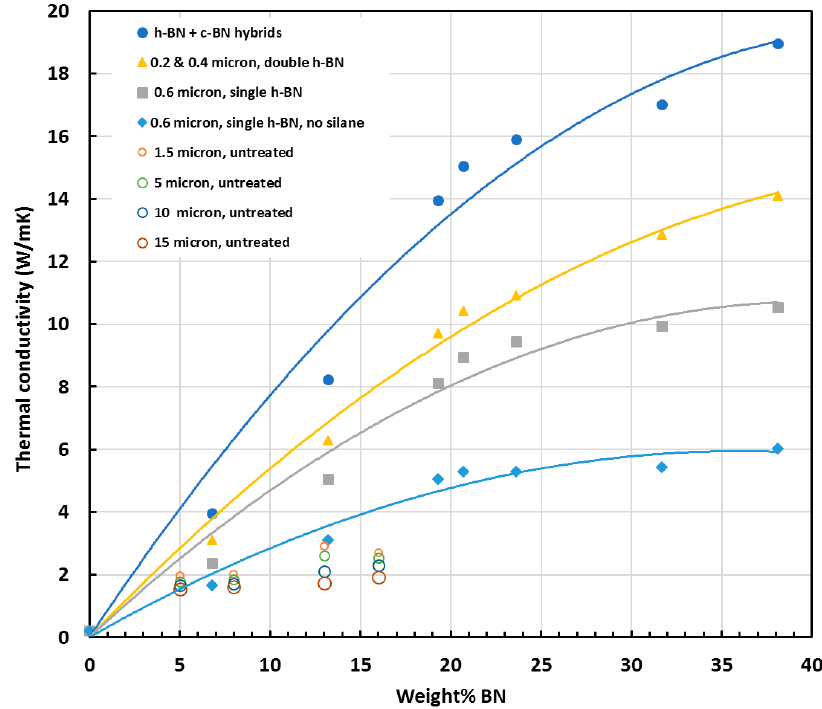
Figure 8. Dependence of thermal conductivity on BN content for epoxy-BN composite systems; data replotted from Yung et al. [54,151]. Filled symbols for silane-treated particles unless otherwise stated [54]: light blue diamonds, 0.6 μ m single h-BN, without silane; grey squares, 0.6 μ m single h-BN; yellow triangles, 0.2 μ m and 0.4 μ m double h-BN; dark blue circles, hBN+cBN hybrids. Open symbols [151]: 1.5 μ m, 5 μ m, 10 μ m and 15 μ m BN, untreated, symbol size increasing with BN particle size.